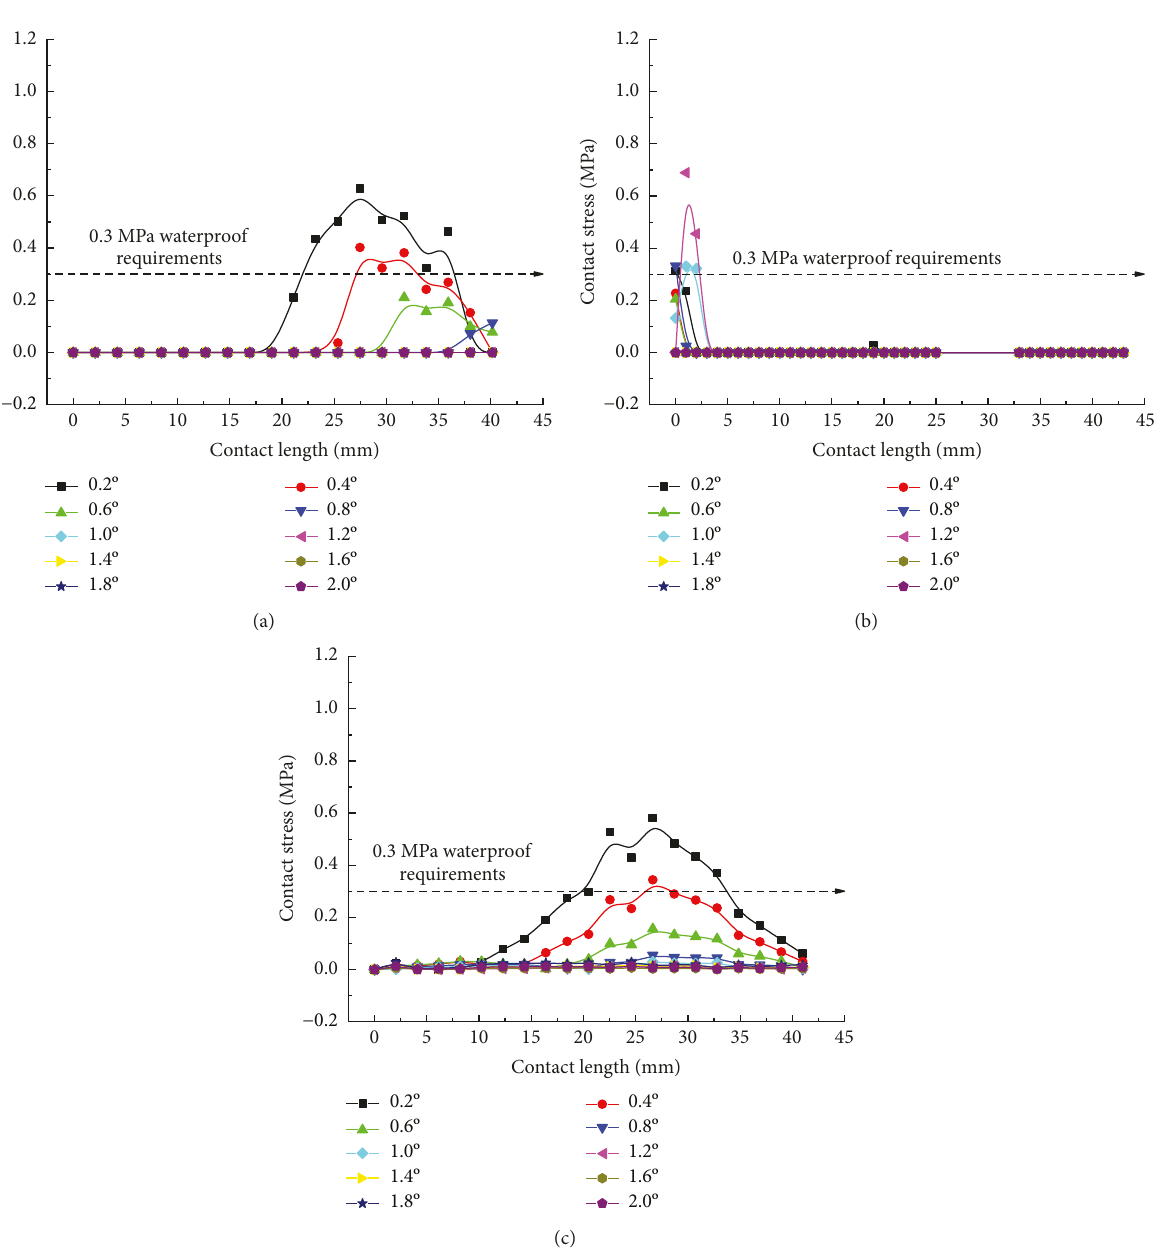
Figure 25: Contact stress curve of the first rubber ring after optimizing during anticlockwise rotation: (a) contact pressure of line 1 for the first rubber ring, (b) contact pressure of line 2 for the first rubber ring, and (c) contact pressure of line 3 for the first rubber